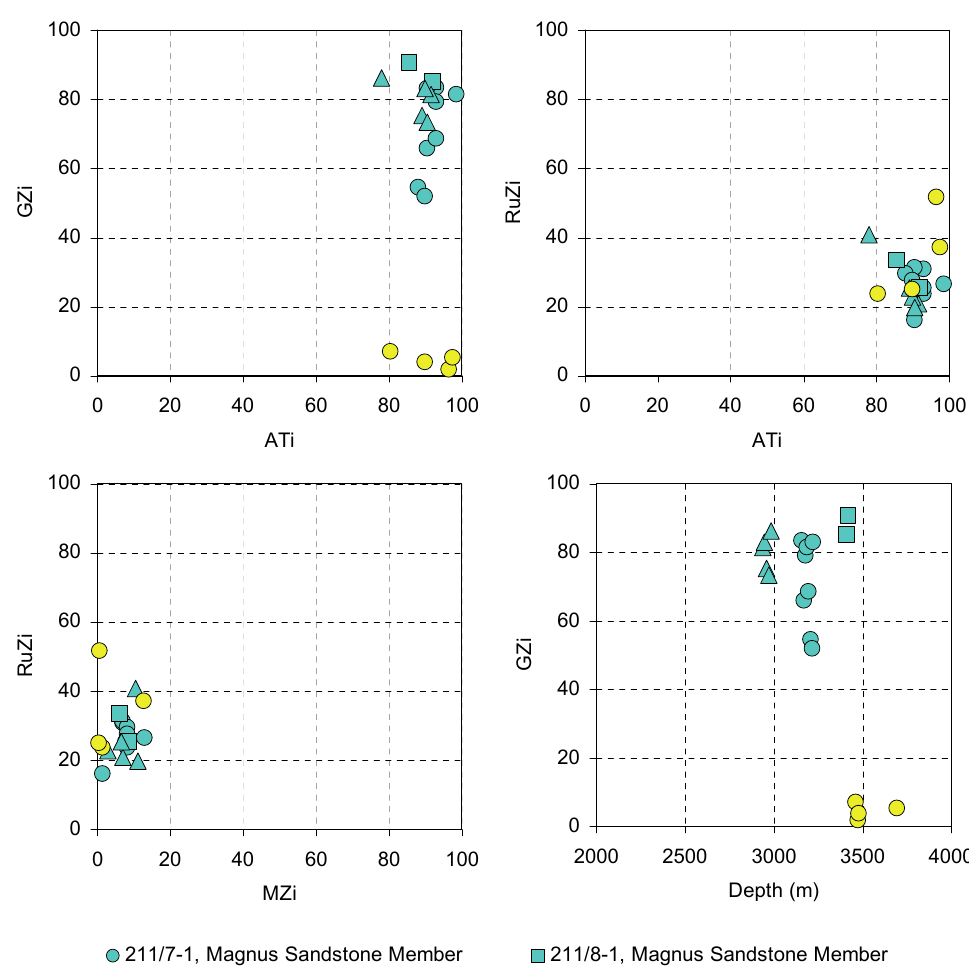
Figure 10. Provenance-sensitive heavy mineral ratios for the Magnus Sandstone and Ptarmigan Sandstone members in the Magnus Field (see Figure 1). Note that there is no clear discrimination between the two sandstones in terms of ATi, RuZi, and MZi values. GZi is much lower in the Ptarmigan sandstone but this unit is more deeply buried and the lower GZi is likely to be a function of greater diagenetic